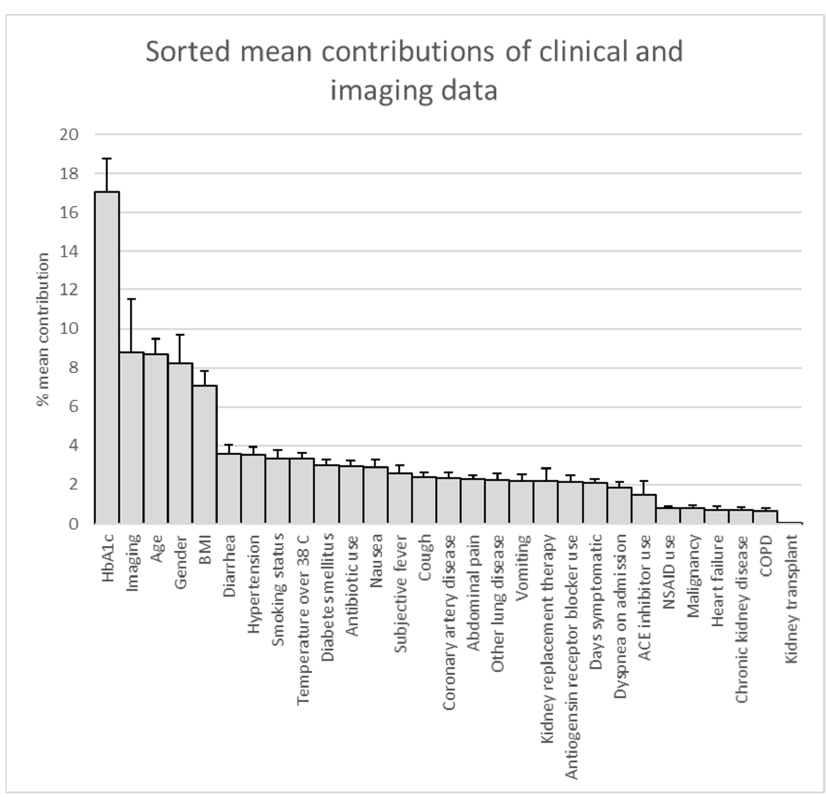
Figure 4. Pareto chart for the LIME analysis results for the predictive model using imaging and demographic and other clinical variables. Predictors are shown in order of descending mean contributions.